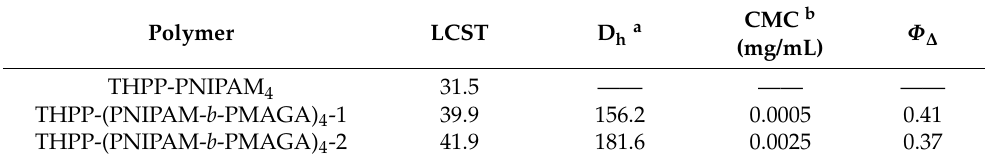
Figure 4. ( a , b ) Temperature dependence of optical transmittance at wavelength of 500 nm obtained for aqueous solutions and Plot of the I 383 /I 372 ratio against log C of THPP-PNIPAM 4 and THPP-(PNIPAM-b-PMAGA) 4 −1 ; ( c ) Average size of THPP-(PNIPAM-b-PMAGA) 4 micelles at 35 °C; ( d ) Average size of THPP-(PNIPAM-b-PMAGA) 4 micelles 45 °C (the concentration of copolymer was 1 mg·mL −1 ). Table 2. Characterization of THPP-(PNIPAM- b -PMAGA) 4 .